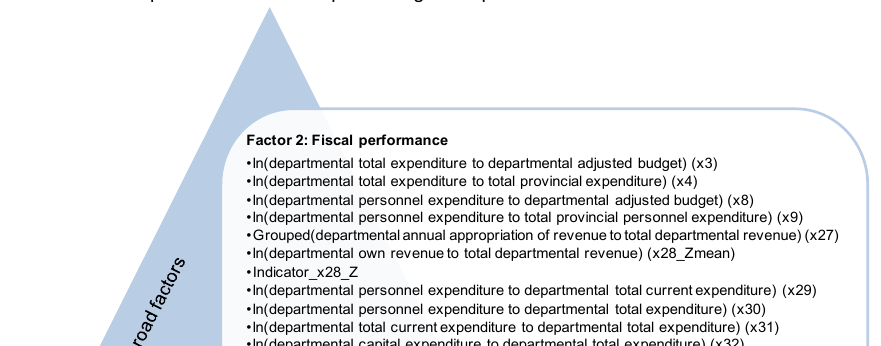
Independent variables representing fiscal performance broad factors